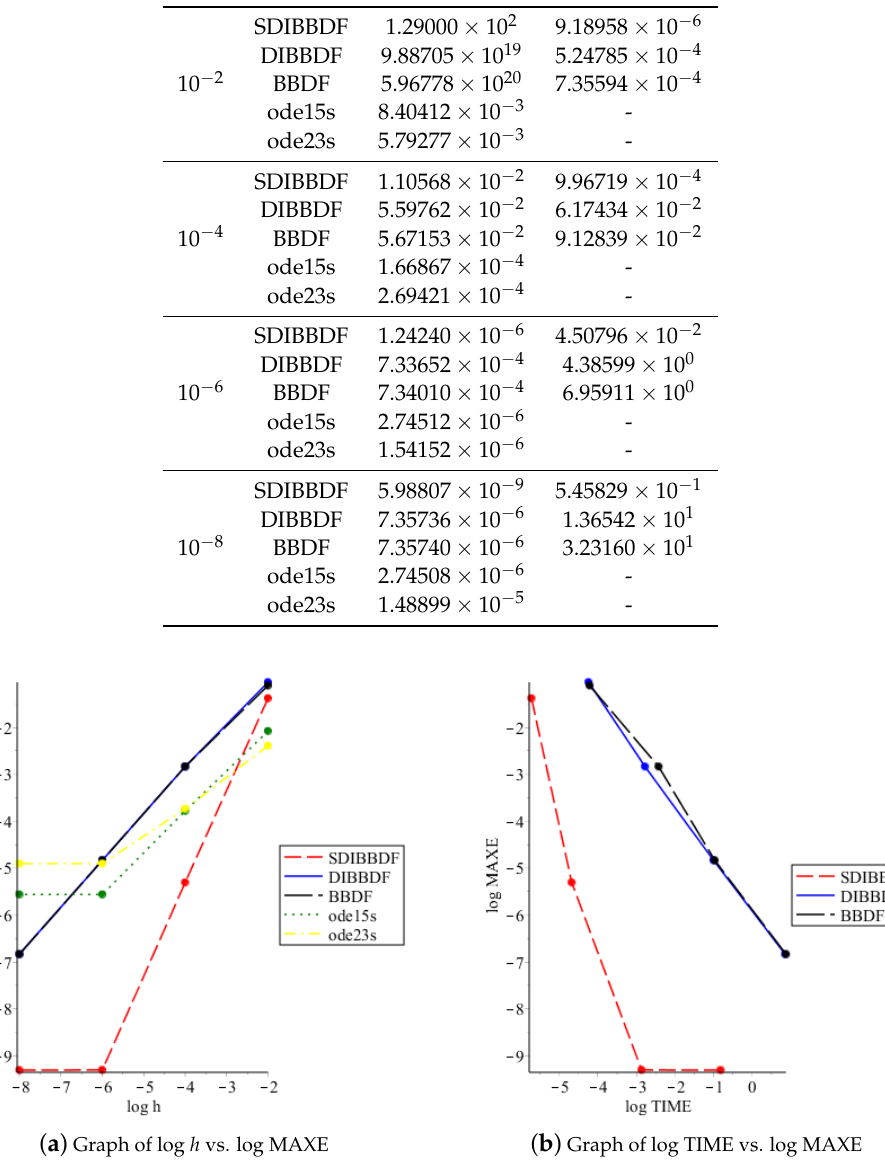
Figure 5. Efficiency curves for test problem